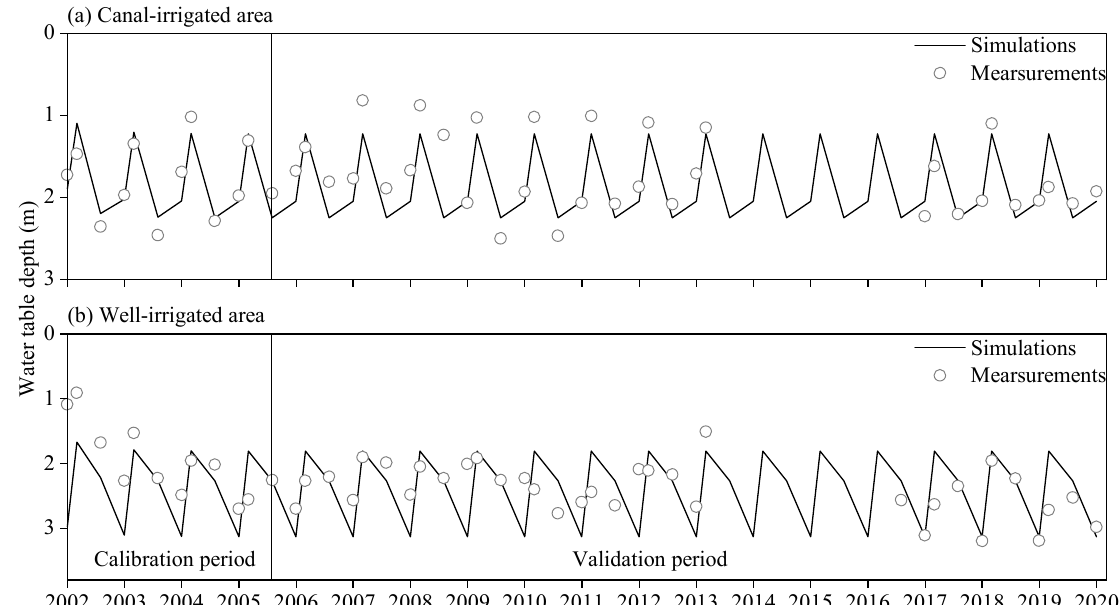
Figure 7. A comparison of results of simulated and observed water table depths of the Longsheng well-canal conjunctive irrigation area during the calibration and validation periods.